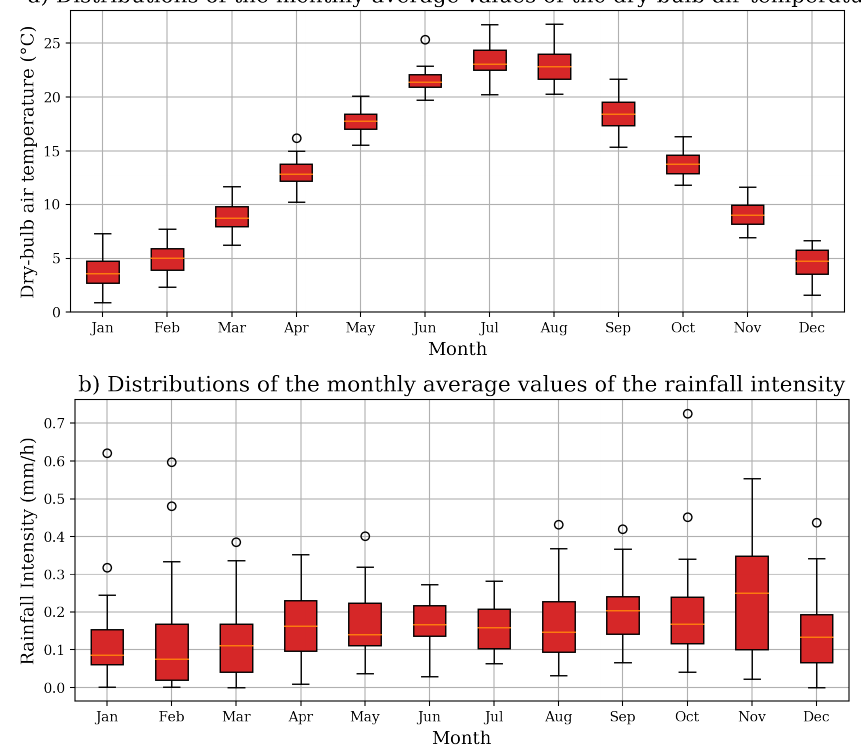
Figure 3. Box-plot of the monthly mean air dry-bulb temperature ( a ) and of the monthly mean rainfall intensity ( b ) in Udine for each year considered in the MY grouped by month. Lower and upper box boundaries are the 25th and the 75th percentile, respectively, the line inside the box is the medina, the lower and the upper error lines are the 10th and the 90th percentiles, respectively, the data falling outside the 90th and the 10th percentiles are represented by